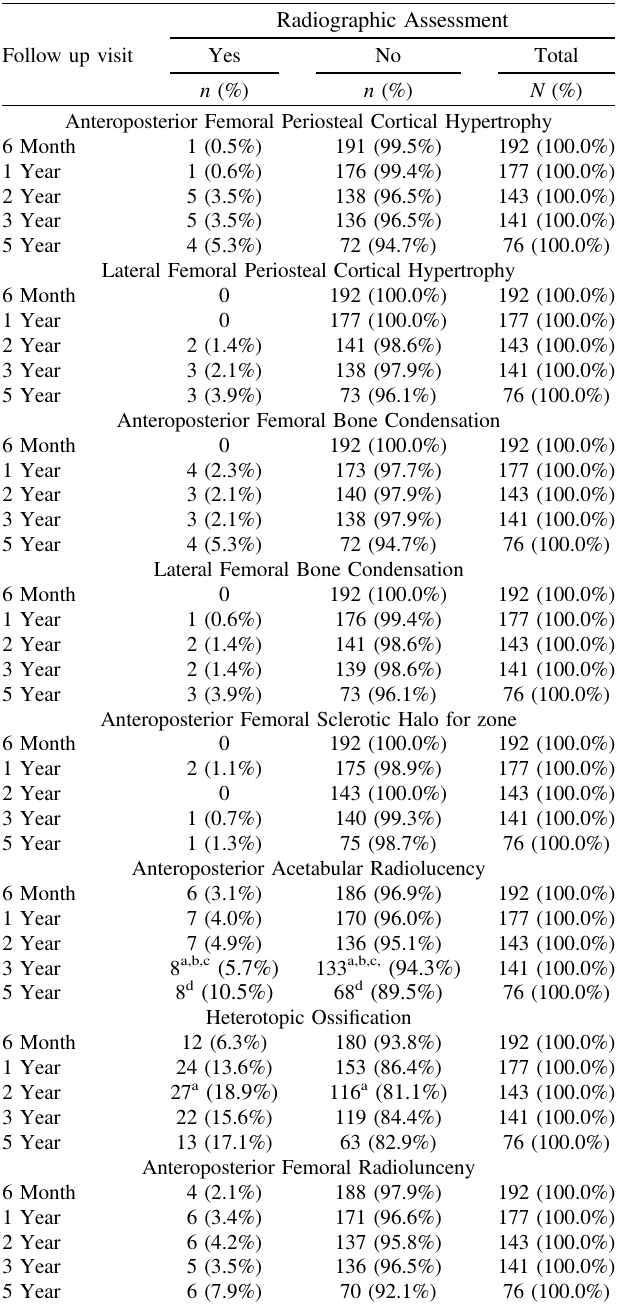
Table 2. Radiographic assessment at each follow-up; Comparison by time assessment was performed using Bonferroni adjusted p -value.